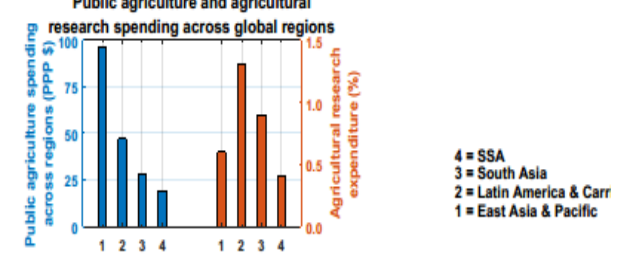
Figure 20. Public agriculture-related expenditures across developing